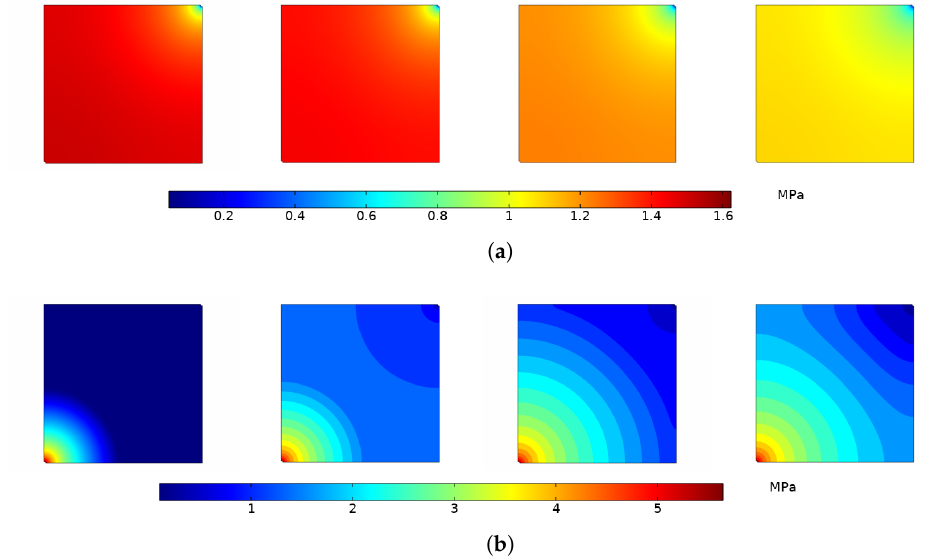
Figure 7. 300 days, 500 days, 1000 days, 1500 days reservoir pressure distribution cloud ( a ) CBM ( b ) CO 2 - ECBM